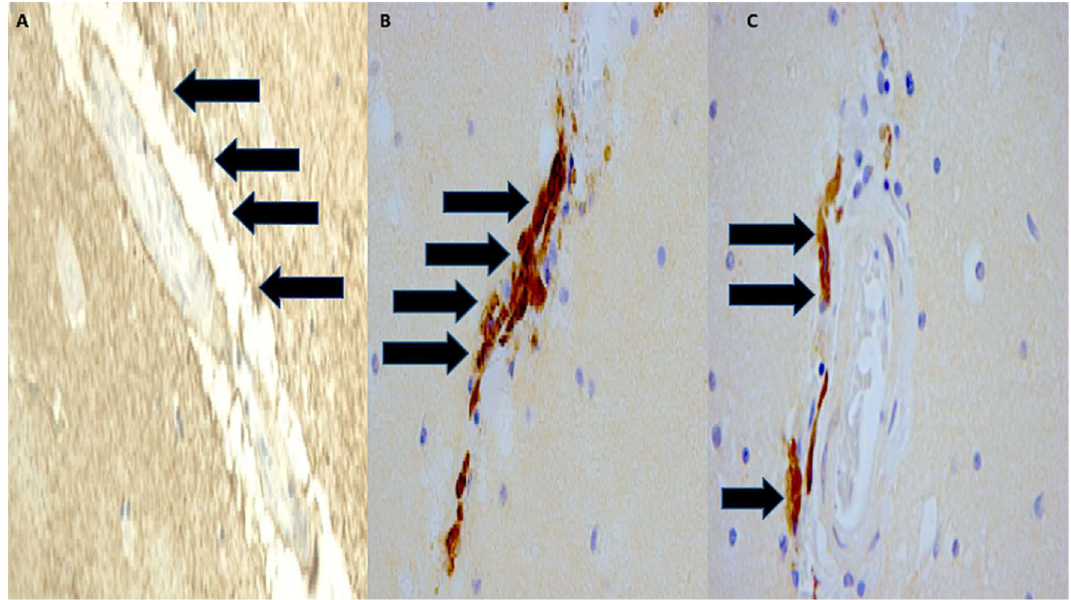
Figure 7. HIF-1α immunopositivity (black arrows) increased significantly at ( A ) early time points of survival (one and three days of survival) until seven days. ( B , C ) Group 4: diffuse perivascular positivity) (magnification 150×).